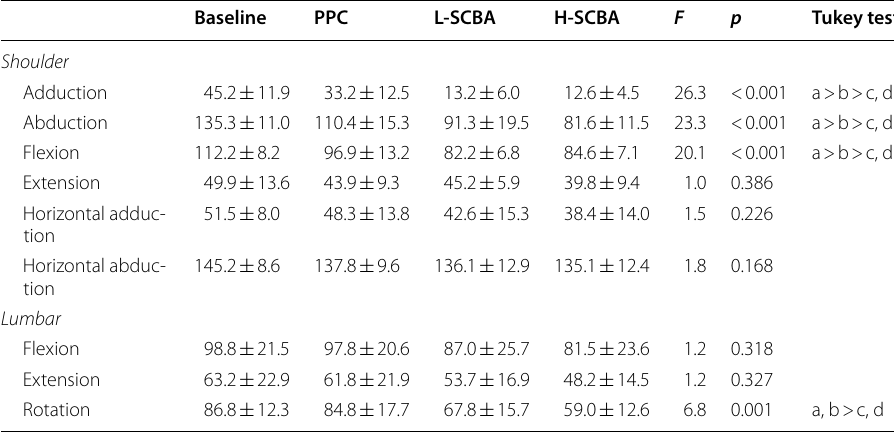
The values are presented in degrees Results are presented as mean